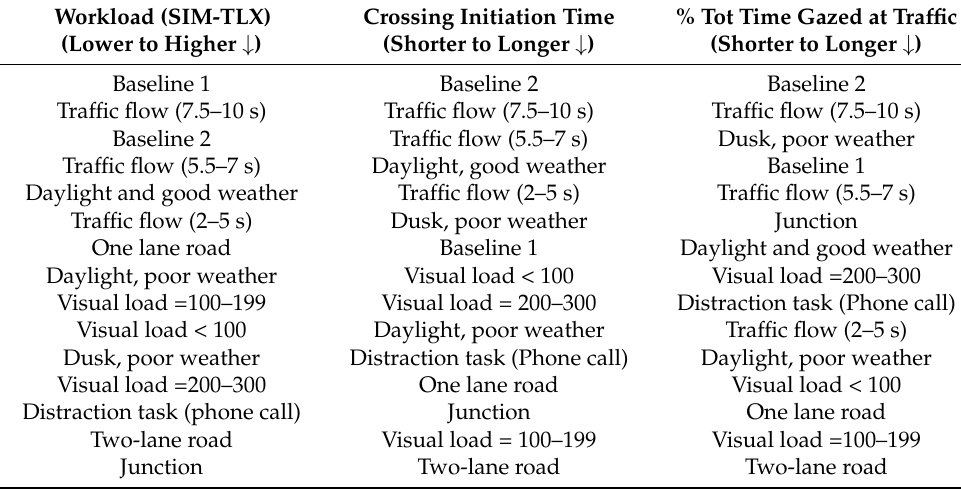
Table 6. Subjective and objective data by scenarios from the lowest to the highest value, as indicated by the